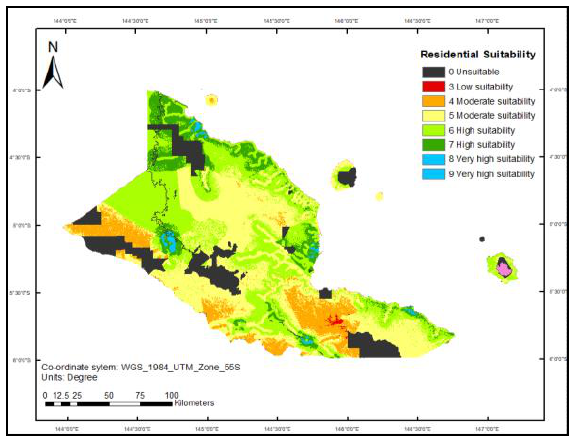
Figure 12. Commercial land-use suitability maps of General AHP